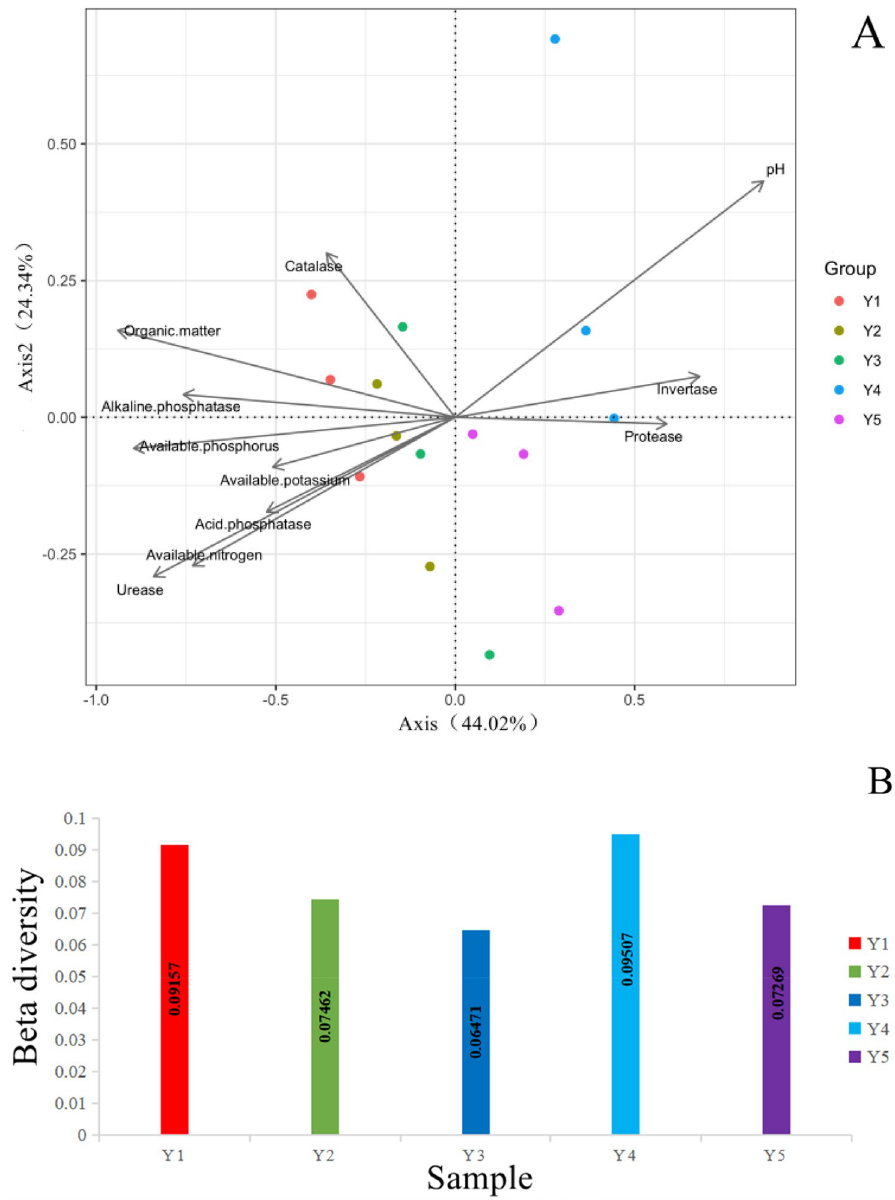
Figure 5. ( A ) db-RDA on bacterial communities and soil bio-chemical factors and ( B ) Intra group beta diversity bacterial communities in the rhizospheric soils of F. taipaienses with different cultivation years. Acid phosphatase: activity of acid phosphatase; Alkaline phosphatase: activity of alkaline phosphatase; Catalase: activity of catalase; Invertase: activity of invertase; Organic matter: content of organic matter; Protease: activity of protease; Urease: activity of urease; Available nitrogen: content of available nitrogen; Available phosphorus: content of available phosphorus; Available potassium: content of available